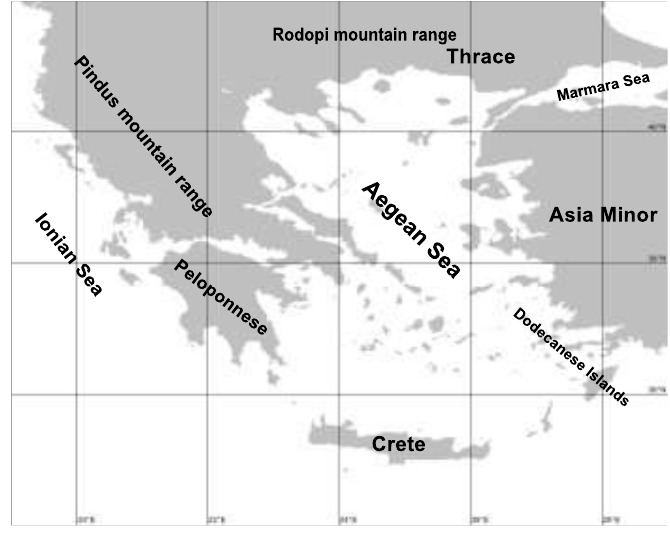
Figure 1. The geographical domain used.